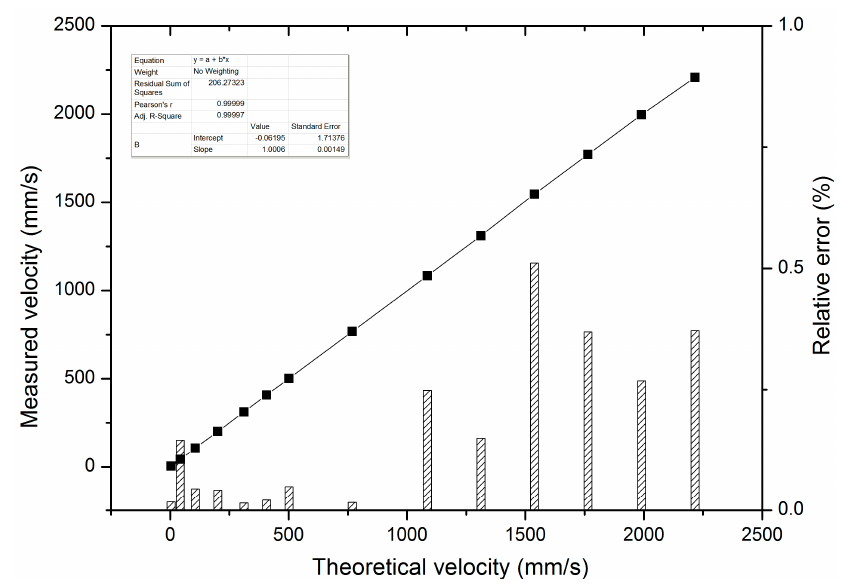
Figure 7. The relative error of measured velocity and theoretical velocity.